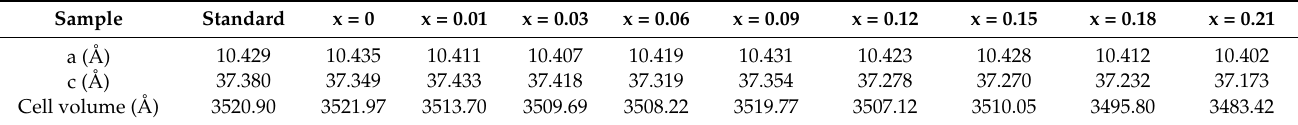
Table 2. Lattice parameters of Ca 1.8 Li 0.6 La 0.6 − x (PO 4 ) 2 :xDy 3+